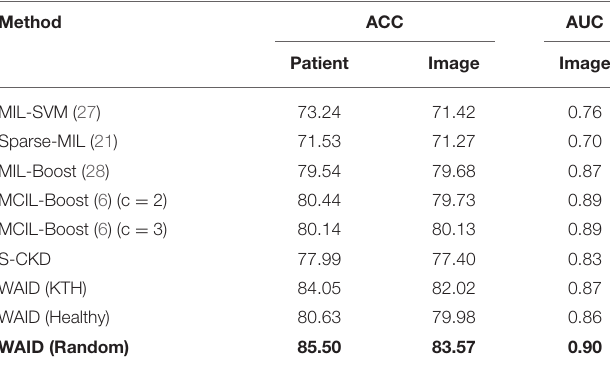
TABLE 3 | Comparisons against different frameworks for weakly supervised data on BreakHis.